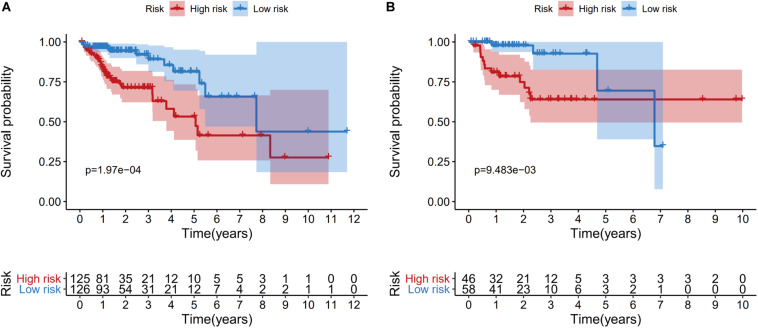
Kaplan-Meier curves of overall survival for the high-risk and low-risk patients in the training dataset (A) and the testing dataset (B).